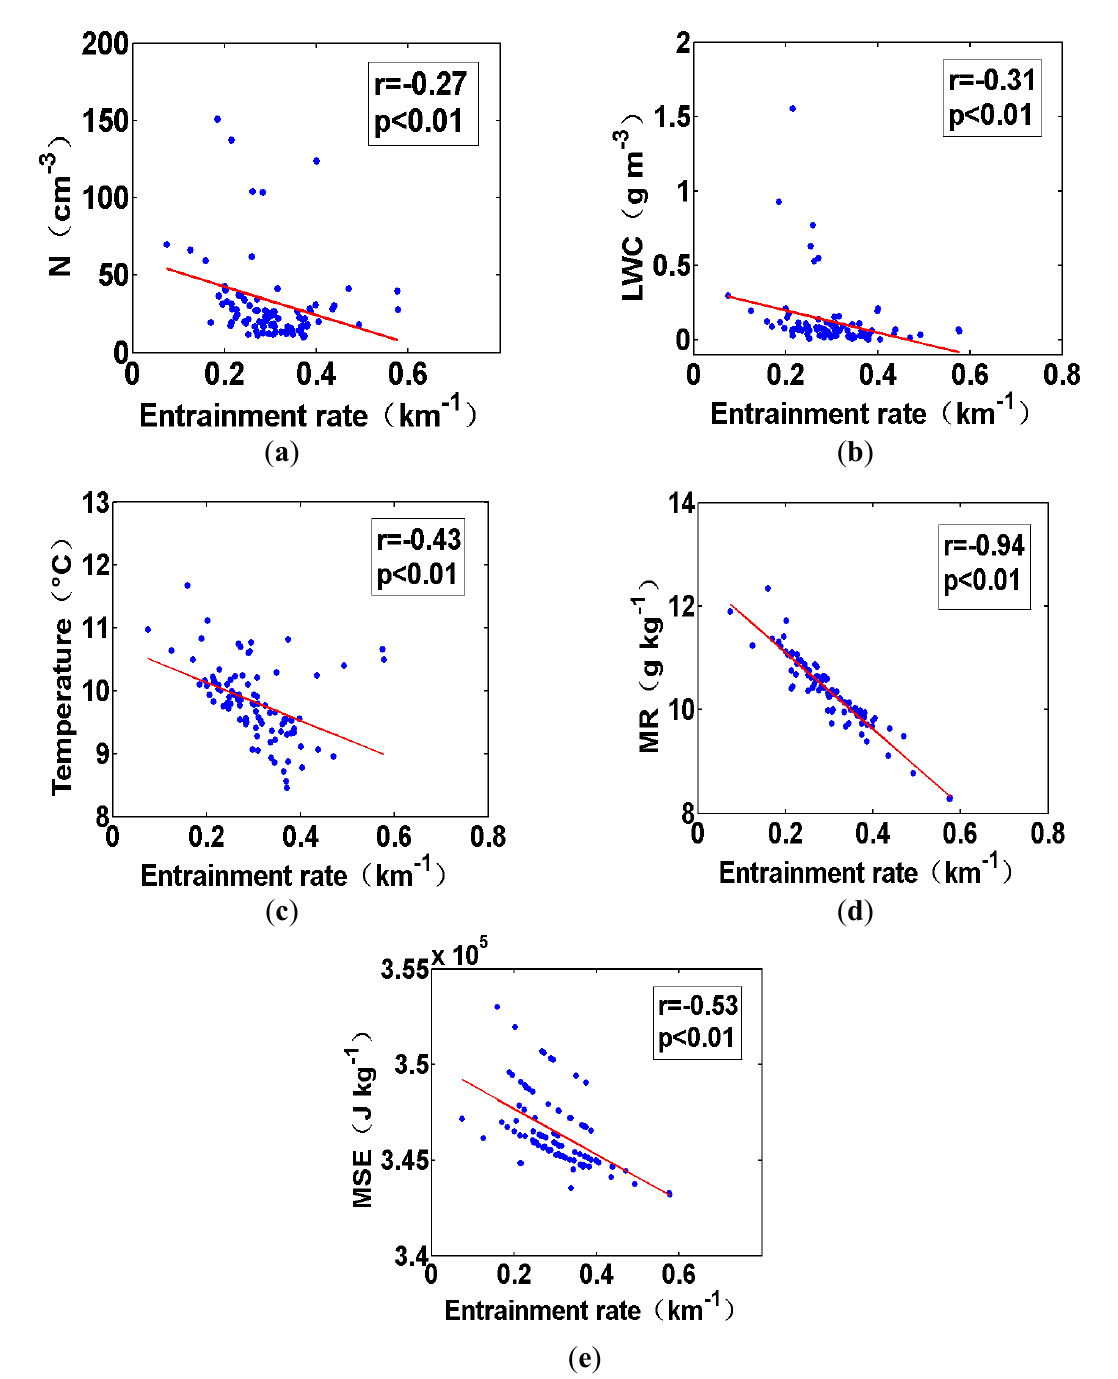
Figure 4. Scatter plots of entrainment rate vs. ( a ) cloud droplet number concentration ( N ), ( b ) liquid water content (LWC), ( c ) temperature ( T ), ( d ) water vapor mixing ratio (MR), and ( e ) moist static energy (MSE) in clouds. Each legend provides the correlation coefficient ( r ) and the p value (a function used for testing a statistical hypothesis) of the